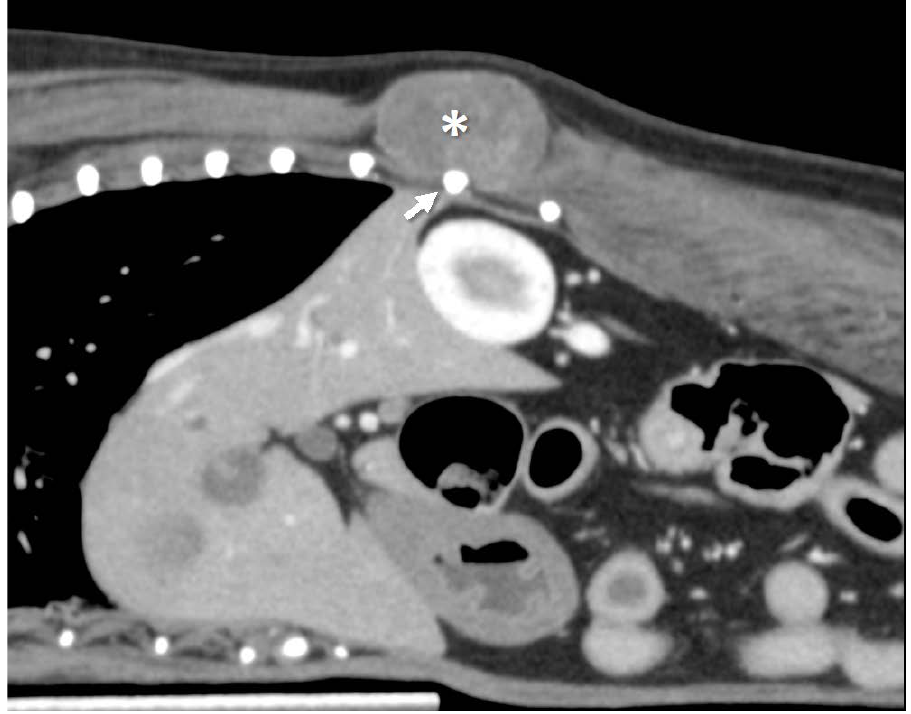
Figure 1. Contrast-enhanced CT image, sagittal plane. The tumor is adjacent to the 12th rib. The dog was positioned ventrally, with the cranial side on the left side of the image. The * indicates the tumor; the arrow indicates the 12th